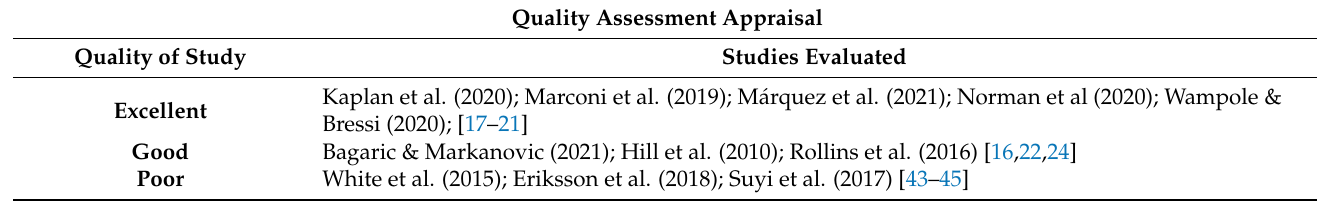
Table 5. Stage 2 Quality Assessment Appraisal for Interventions. Quality Assessment